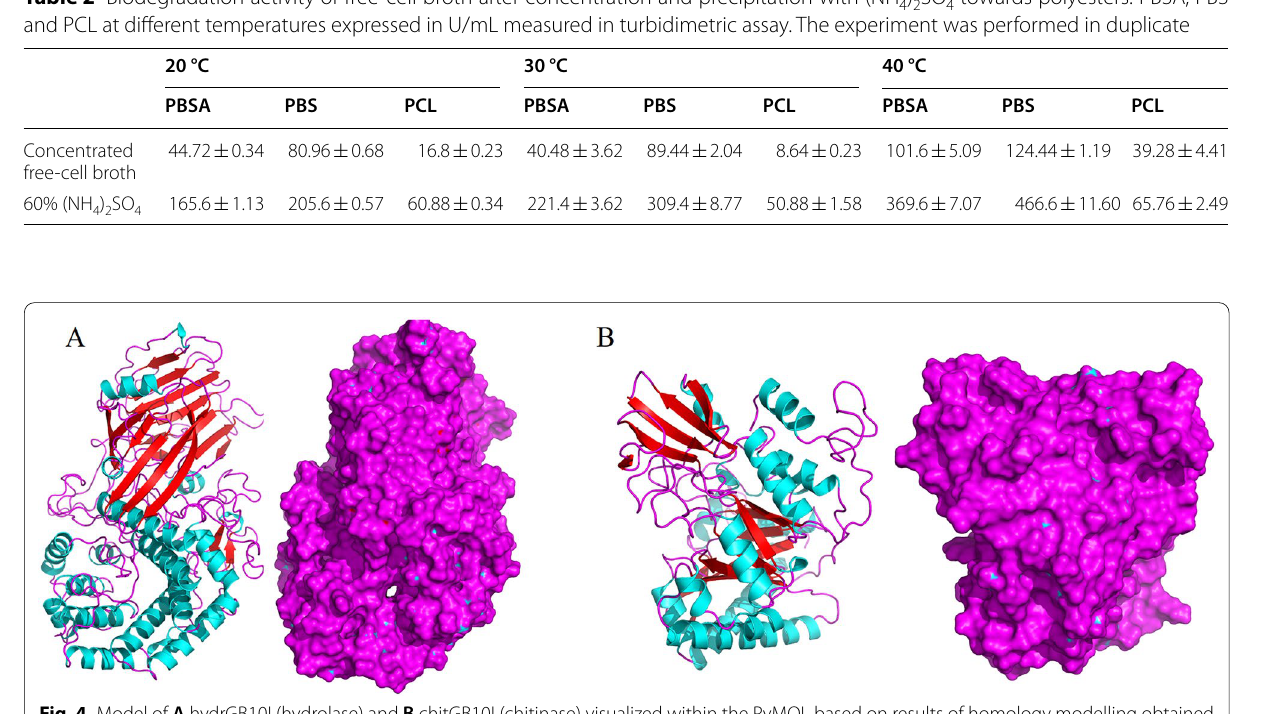
) SO towards polyesters: PBSA, PBS 4 2 4